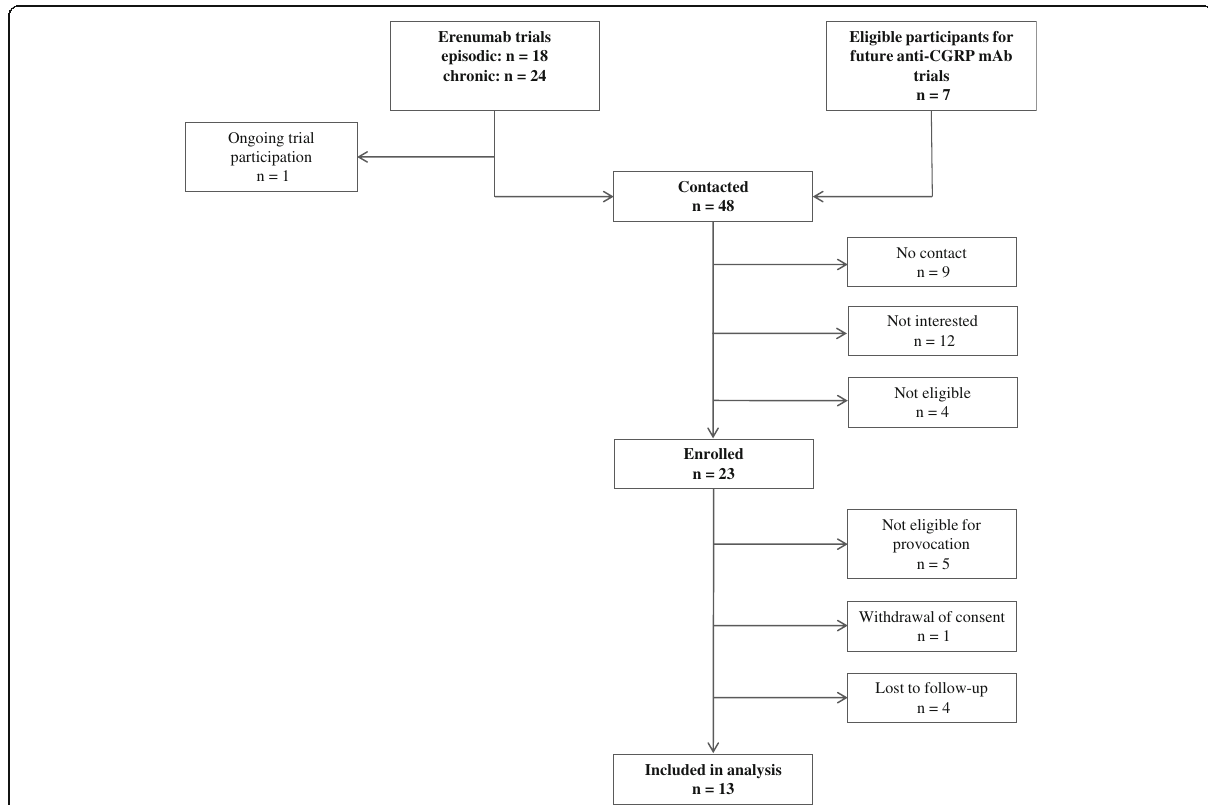
Fig. 3 Inclusion flowchart. Twenty-three patients were enrolled in the study. Ten of these were excluded subsequently. One patient was excluded due to a cardiac conduction disease and one due to diabetes mellitus (well-regulated), according to the conventional CGRP provocation protocol. Three patients were excluded from analysis as they did not participate in the erenumab trials. One patient withdrew consent before the experiments. Four patients were lost to follow-up and one of these had participated in the first study day. Data from these days were excluded from analyses. Of the ten patients, who were excluded, seven had received erenumab and six of these were high responders. Response status was not obtained from the last of the seven